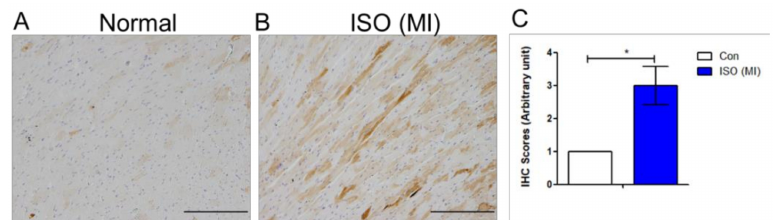
Figure 5. Expression of the Wnt1 protein in the isopretenol-induced myocardial infarction rat model. ( A ) Analysis of Wnt1 protein expression in normal rat by immunohistochemistry. ( B ) Wnt1 protein expression in the isopretenol (ISO)-induced myocardial infarction (MI) rat model ( n = 3). ( C ) Scoring of the tissue slides analyzed by immunohistochemistry: 0 (no staining); 1 (<10% staining); 2 (10–50% staining); 3 (>50% staining). *, p value < 0.05.